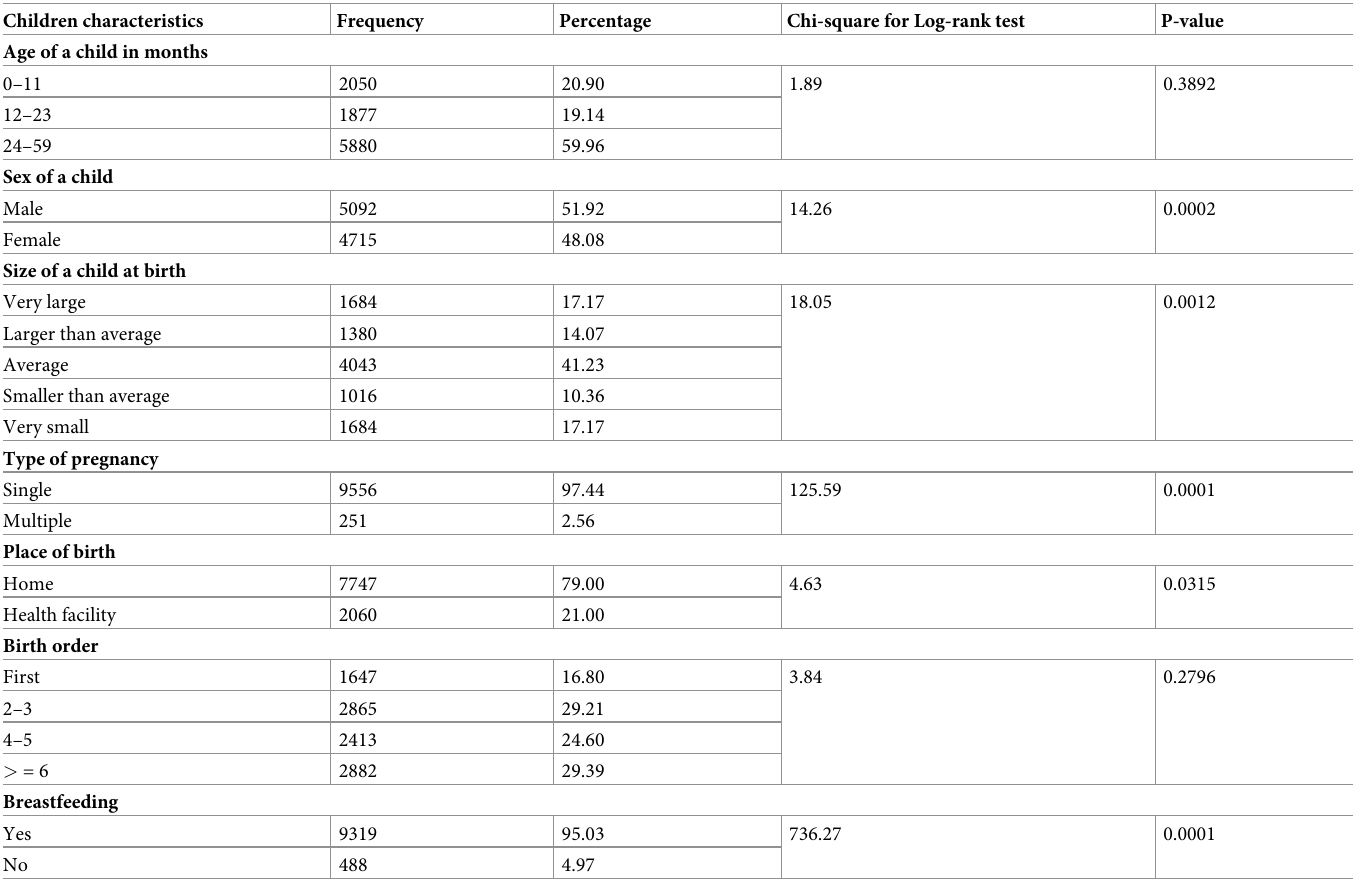
Table 2. Characteristics of under-five children included in the analysis based on the 2016